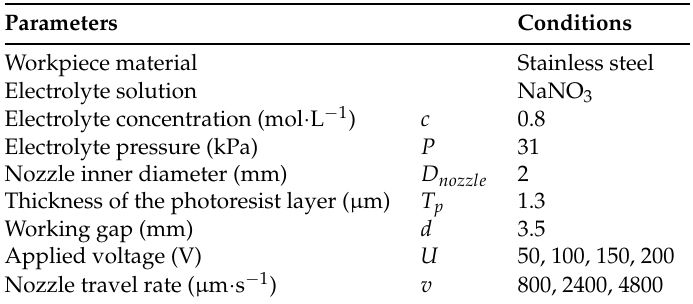
Table 3. Experimental conditions for micro